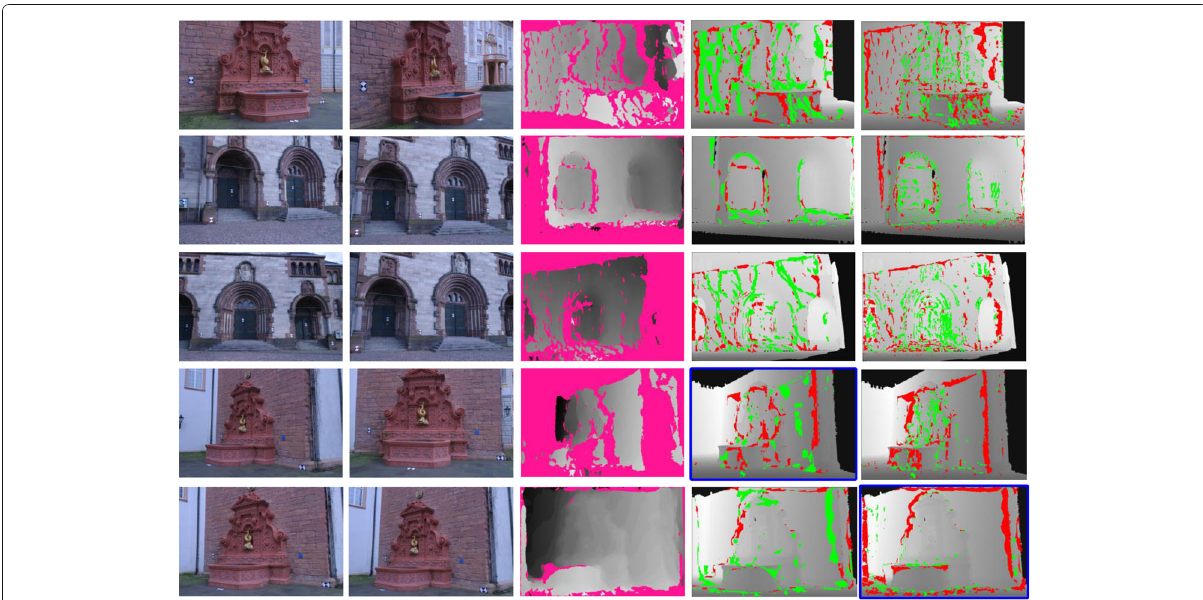
Fig. 9 Representative examples of depth estimation from the Fountain and HerzJesu Dataset. Columns 1 and 2: the stereo pairs. Column 3: depth estimation results by the proposed method, where pink pixels denote occluded pixels. Column 4: comparison of the proposed method with Min et al.’s method [14]. If the depth of a pixel is correctly estimated by the proposed method but incorrectly by Min et al.’s method, the pixel is shown in green color; otherwise, it is shown in red color. Column 5: comparison of the proposed method with the census transform using the same color convention. A blue border around the image indicates the case where the proposed method performs worse compared to the other methods